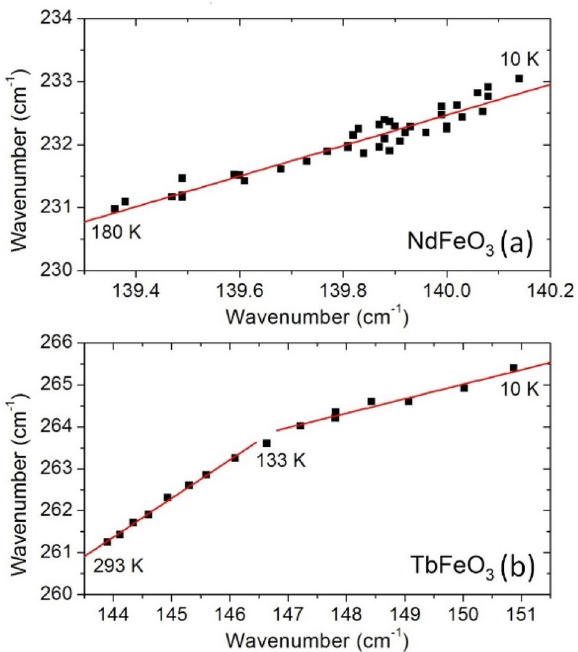
Figure 9. Wavenumber of the [010] pc in-phase octahedra rotation mode as a function of the wavenumber for the ( a ) Nd( z ) and ( b ) Tb( z ) out-of-phase oscillation modes, from 10 to 180 K and to 293 K,